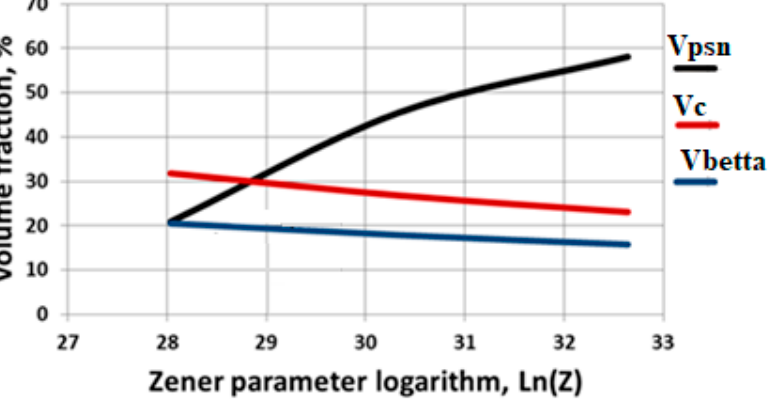
Figure 17. Result of simulation dependence of Cube, β –piber and PSN fraction volume from Zener-Hollomon parameter, with account for intermetallic particle refinement in the AlMg 6 Mn 0.7 (1565 ch) alloy.